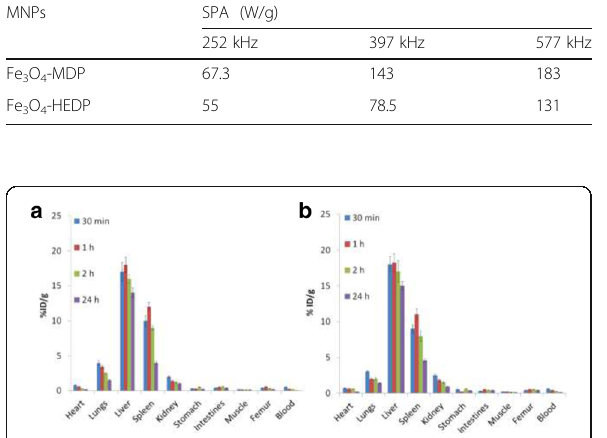
Fig. 1 (abstract OP24). Biodistribution results of ( a ) 99m Tc-Fe 3 O 4 - MDP and ( b ) 99m Tc-Fe 3 O 4 -HEDP